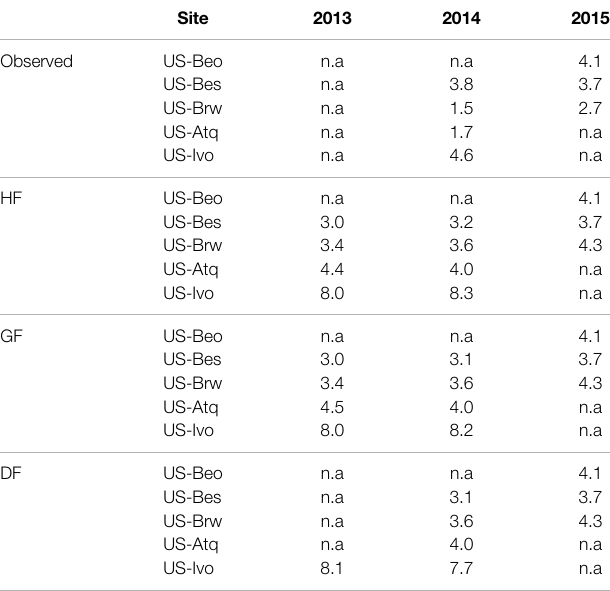
TABLE 3 | Annual estimates of observed and upscaled CH 4 fl ux using the homogeneous footprint (HF), gradient footprint (GF) and dynamic footprint (DF) algorithms for all study sites in 2013 – 2015 (Unit: g C m − 2 year − 1 , n.a.: not available).